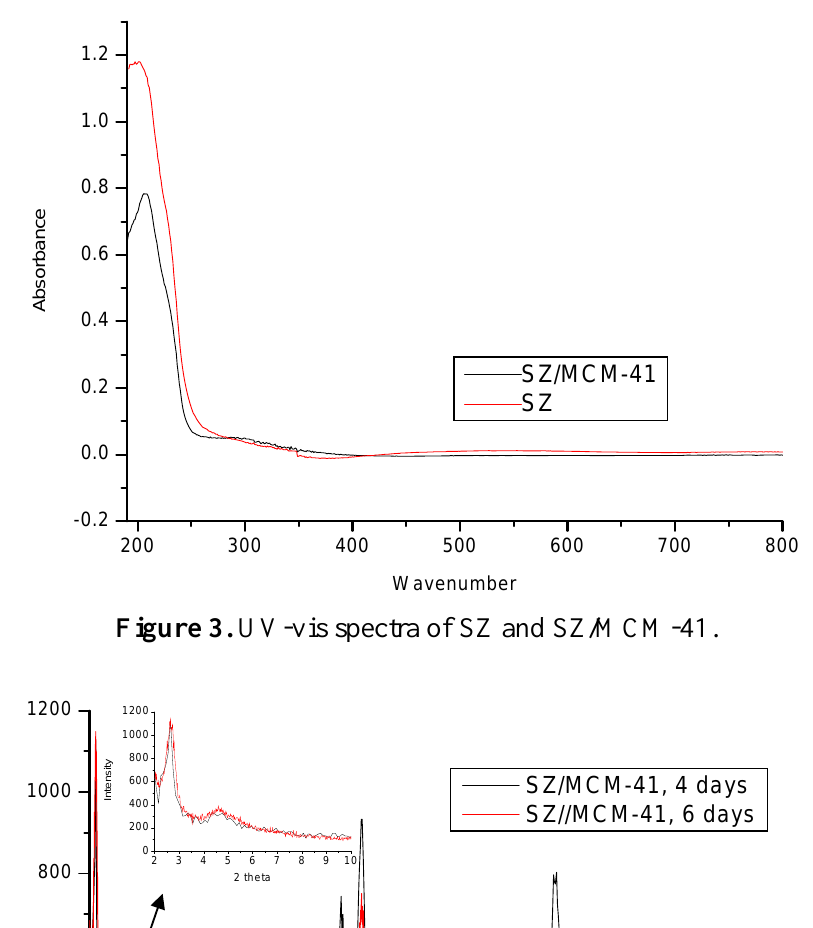
Figure 3. UV-vis spectra of SZ and SZ/MCM-41.